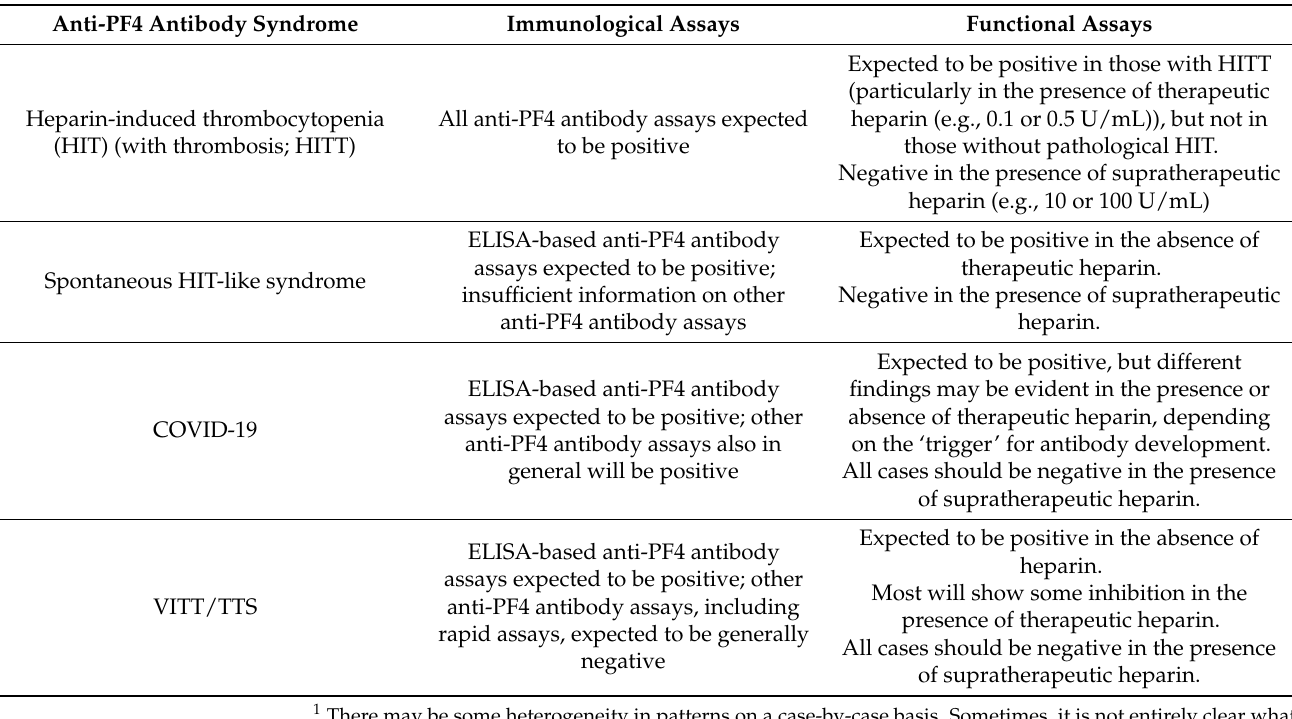
Table 1. Summary table. Expected laboratory test patterns in different types of anti-PF4 antibody syndromes 1